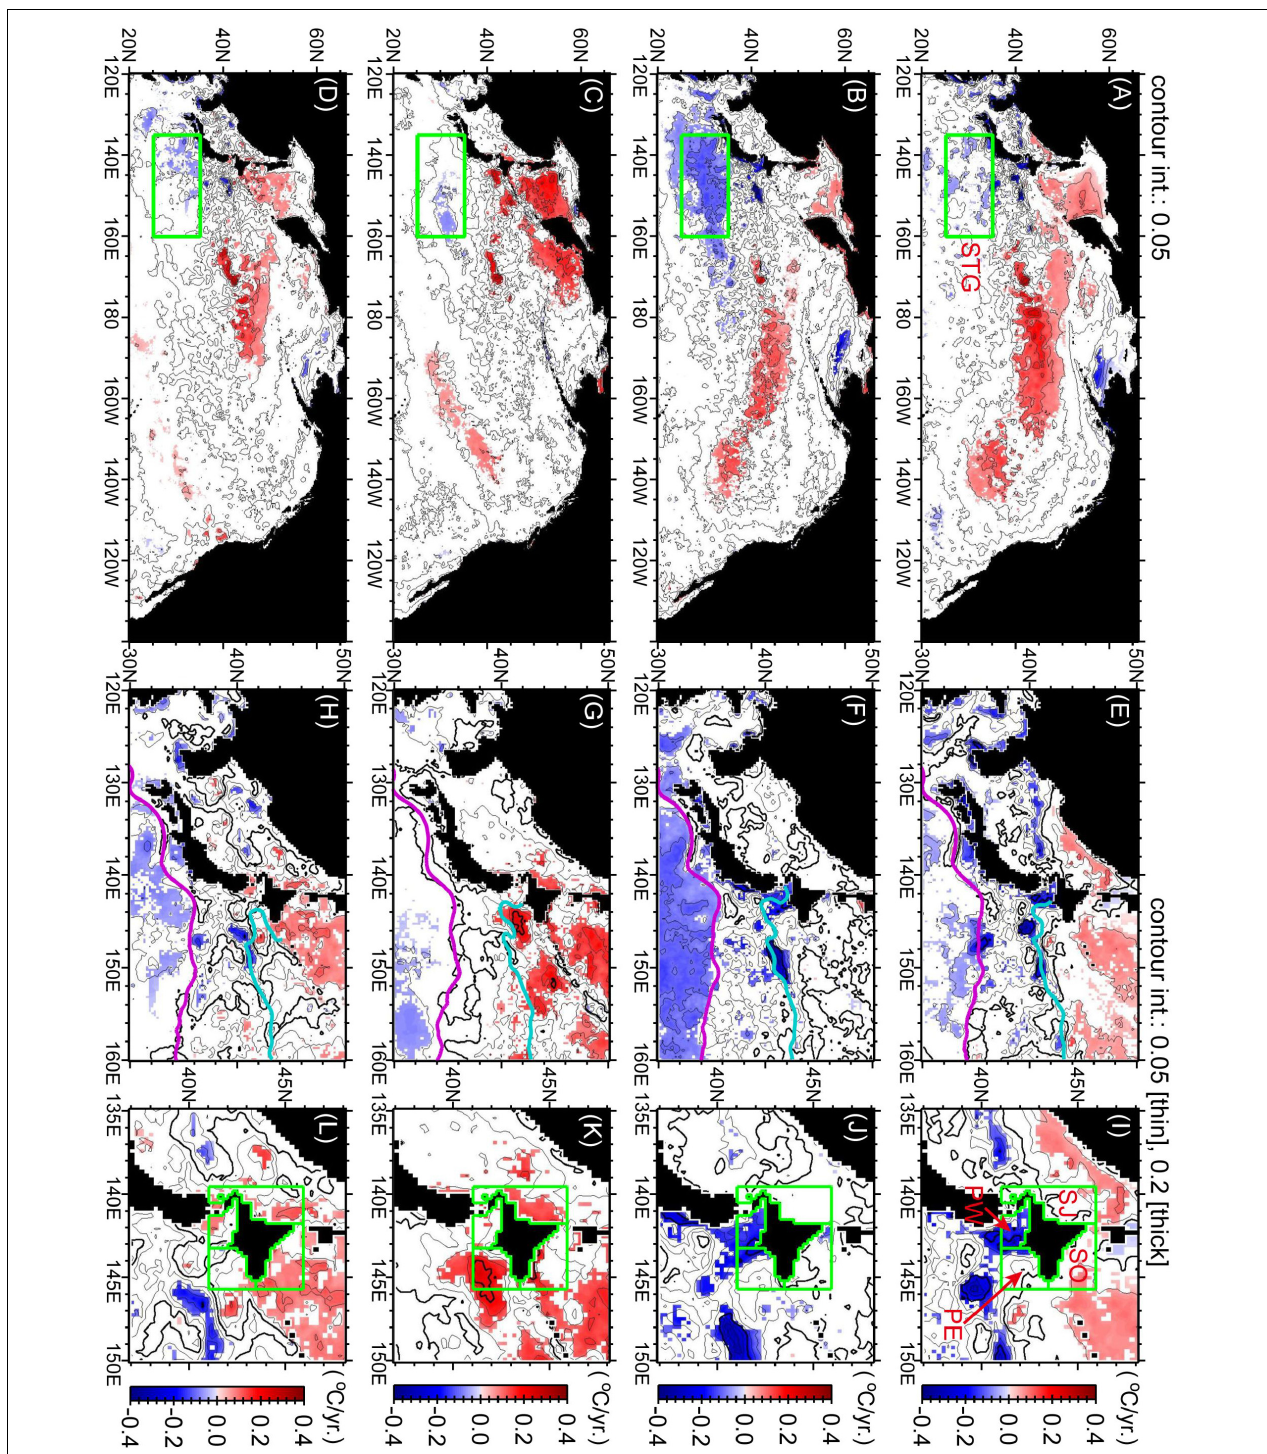
FIGURE 4 | Trends of SSTs in 2000–2014 for winter (top panels), spring (second row of panels), summer (third row of panels), and autumn (bottom panels). Significant trends ( P < 0.10) are shaded blue and red. Illustrated regions and scales are different for the left (A–D) , center (E–H) , and right (I–L) panels. Purple and light blue lines in the center panels indicate seasonal mean positions of the Kuroshio/Kuroshio Extension axis and the Oyashio/subarctic front in 2000 to 2014, respectively, which were estimated from FRA-ROMS. Seasonal mean SSTs are estimated in Figure 5 for the five green boxes in the left and right panels. STG, subtropical gyre; SO, Sea of Okhotsk; SJ, Sea of Japan; PW, Pacific Ocean off the southwest Hokkaido coast; and PE, Pacific Ocean off the southeast Hokkaido coast.